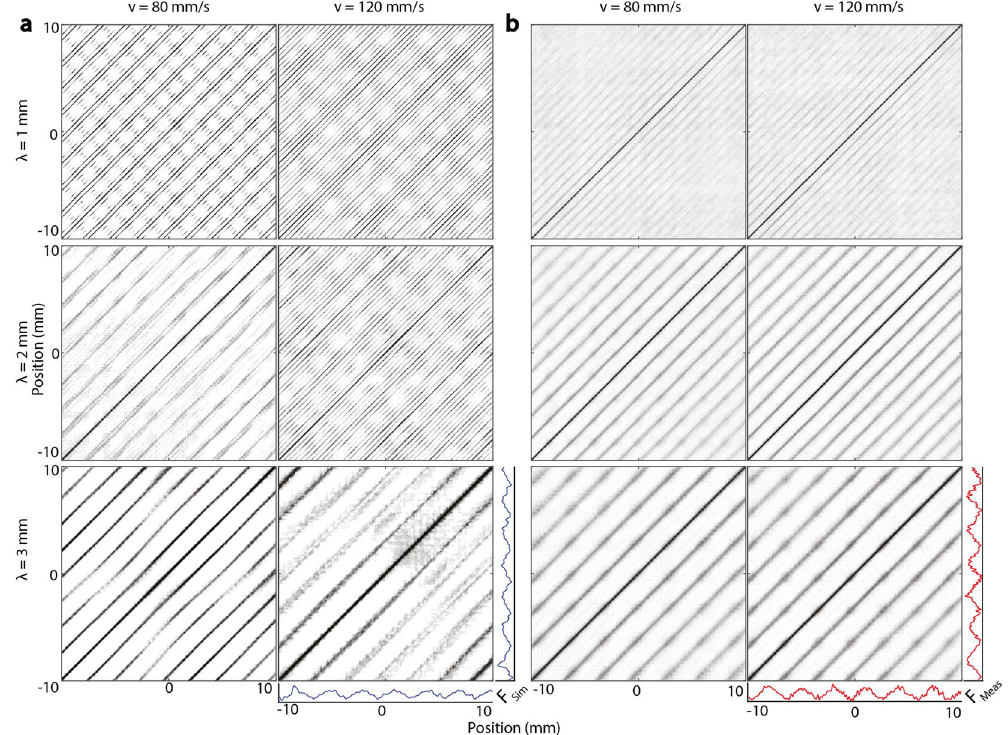
Figure 2. Mean recurrence plots of ( a ) simulated and ( b ) measured forces in all conditions. The diagonal lines reflect the periodicity of the force signals, illustrating the large qualitative agreement between simulated and measured force patterns. Measured and simulated forces exhibited greater regularity for coarser surfaces. A quantitative comparison is made through the joint recurrence analysis presented